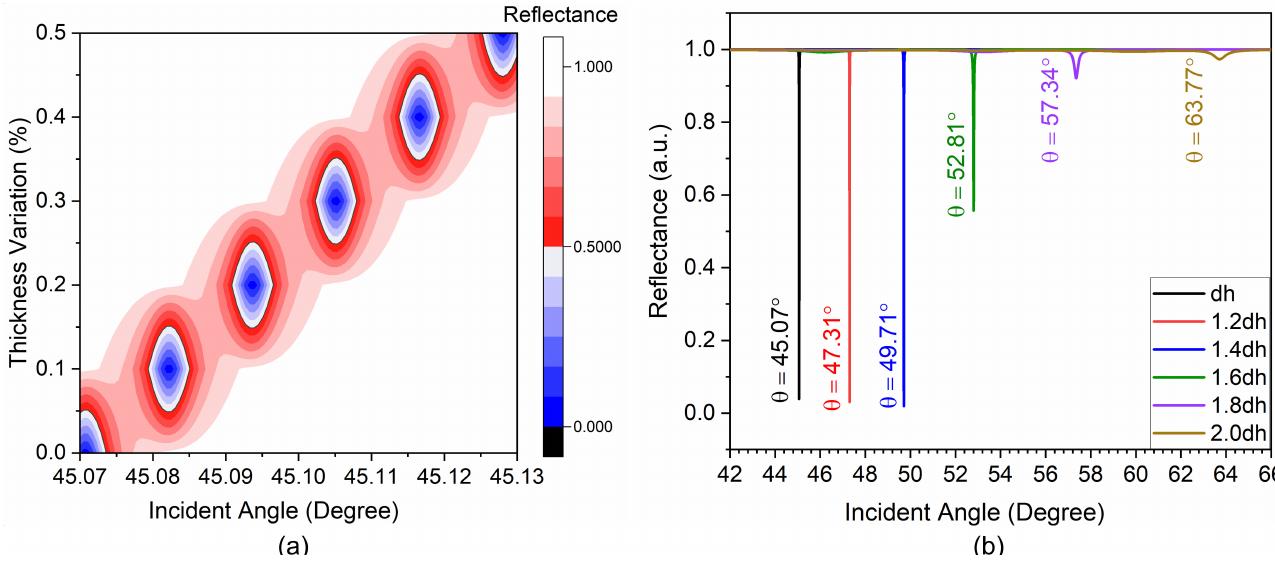
Figure 4. The impact of varying the DAST material width on the required incidence angle to filter out a constant wavelength of 632.8 nm: ( a ) for 0.5% thickness variation; and ( b ) for 100% thickness variations.